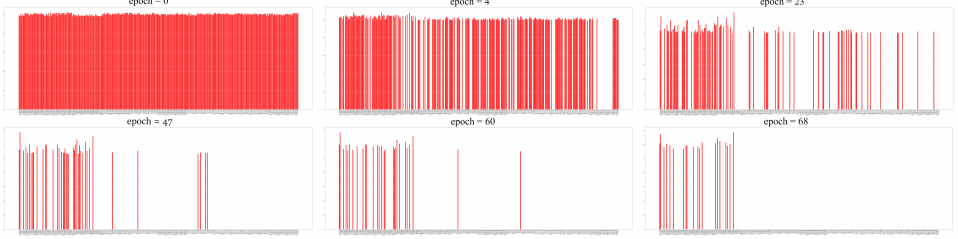
Figure 9. A few steps of the iterative feature pruning process. The red sticks represent the still remaining features and the vertical axis shows the corresponding scores for each feature. As we move forward with the training, the scores change according to the feature’s importance. At a given pruning step, the N deleted _ weights number of features with the smallest magnitude are deleted, until only the desired number of features